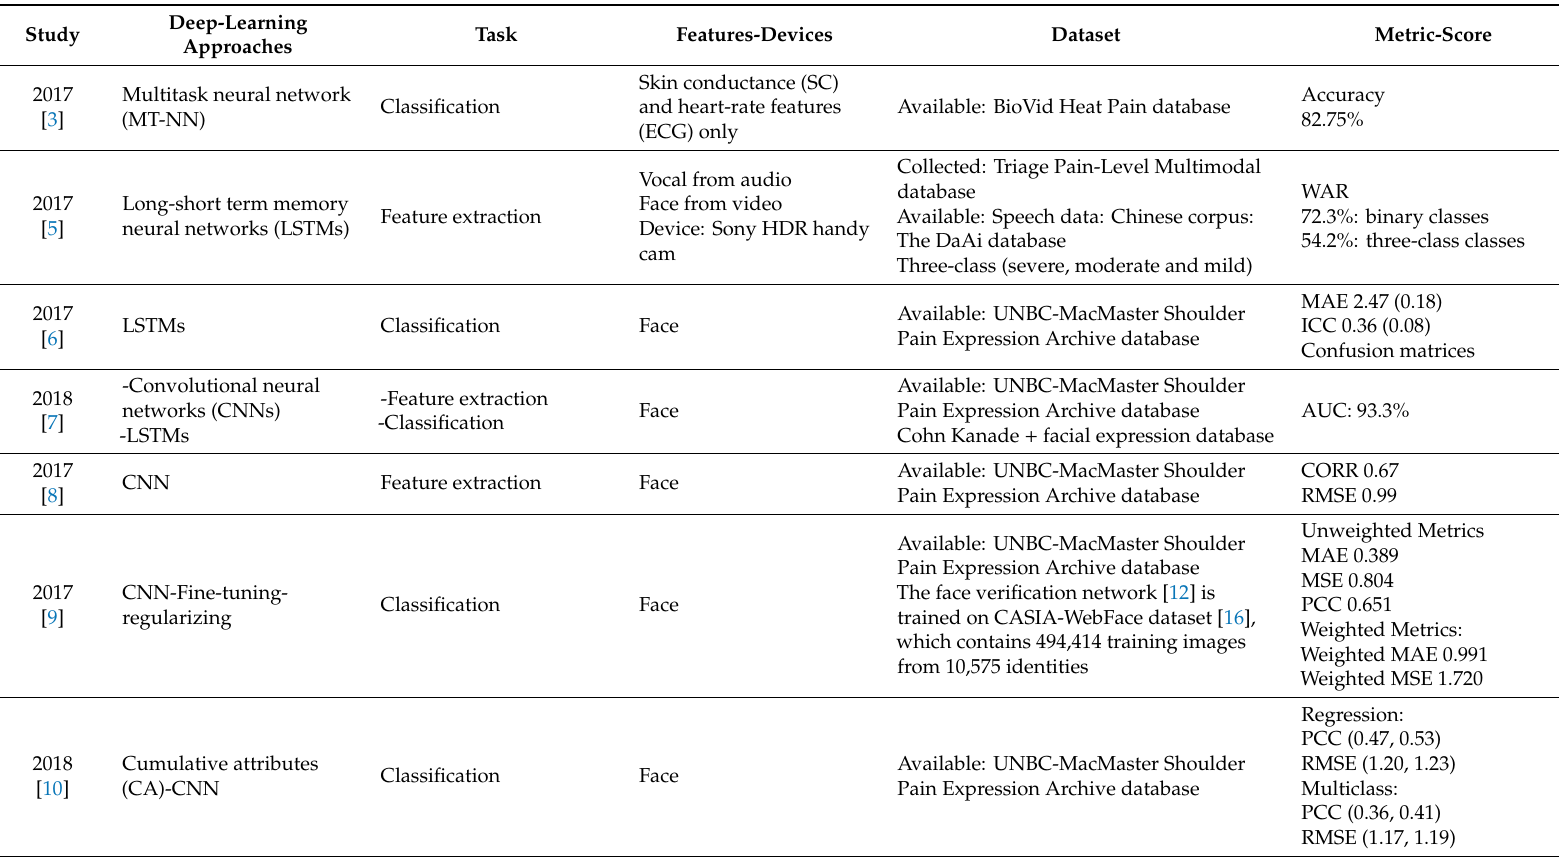
Table 1. Summary of pain-recognition studies based on deep learning. Abbreviations: WAR—weighted average recall; AUC—area under the curve; CORR—Pearson’s correlation; MSE—mean-square error; RMSE—root mean-square error; ICC—intraclass correlation; CC—correlation coe ffi cient; MAE—mean absolute